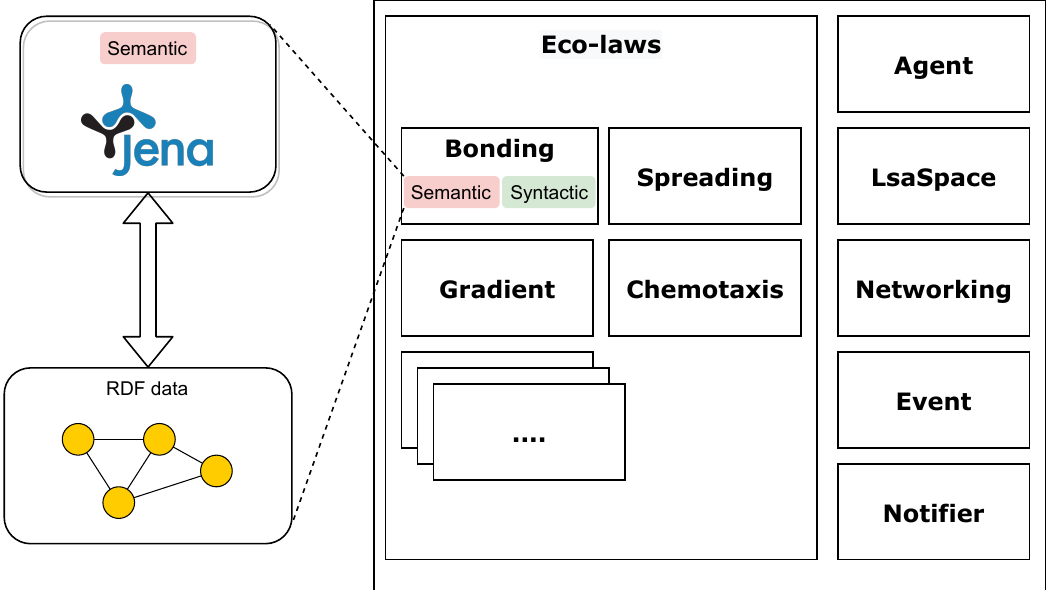
Figure 7. Learning-based semantic coordination middleware extended with Jena rule-based reasoner and RDF data to support semantic